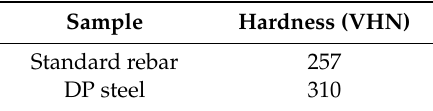
Table 2. Average hardness